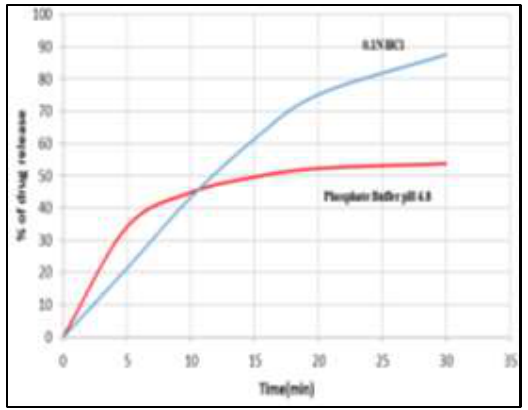
Figure 7. The release profile of F13 nanoparticle in phosphate buffer pH 6.8 and 0.1N